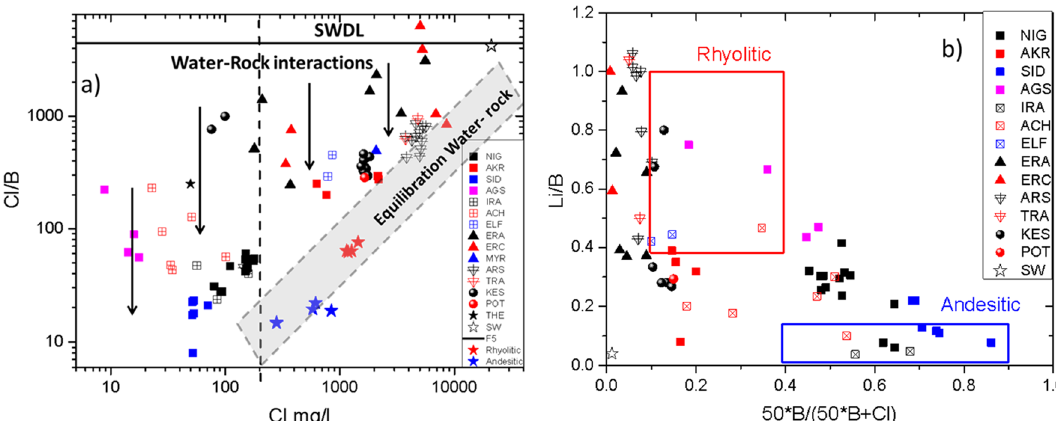
Figure 4. ( a ) Cl versus Cl/B of the thermal waters for the studied areas. The arrows indicate water–rock interactions. Equilibration water–rock line is depicted (shaded area-the edge points represent the interaction of thermal water with the aquifer matrix). ( b ) Li/B versus 50*B/(50*B + Cl) of the thermal waters. The rectangular shapes represent the ratios of Andesitic and Rhyolitic rocks.